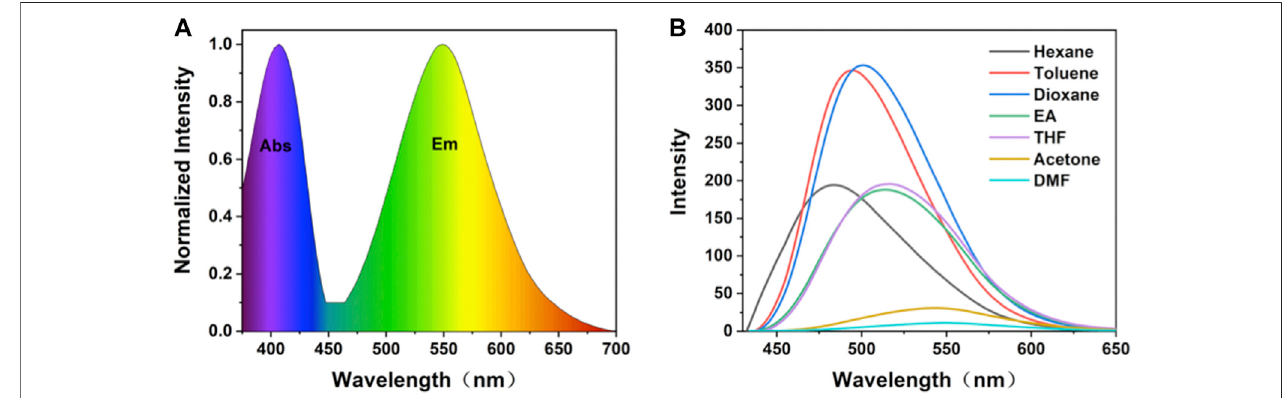
FIGURE 2 | (A) Normalized absorption and fl uorescence emission spectrum of (OMeTPA)2Pyr in DMF; (B) Fluorescence spectra of (OMeTPA)2Pyr in variant solvents ( λ ex (cid:1) 427